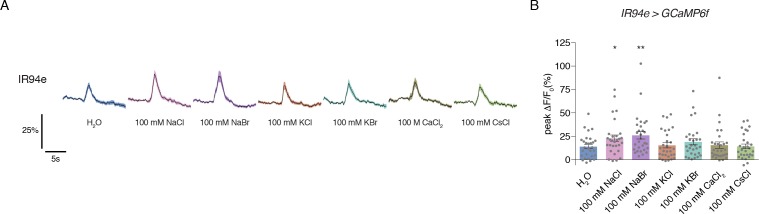
IR94e neurons show weak, low sodium-specific responses to salt.(A) Time curves of GCaMP6f signal in IR94e GRNs following stimulation with indicated tastants. Lines and shaded regions indicate mean ±SEM. (B) Peak changes during stimulation of IR94e neurons with each tastant. Bars represent mean ±SEM, n = 29. Asterisks indicate significant difference from water by one-way ANOVA with Bonferroni post hoc test, *p<0.05, **p<0.01.